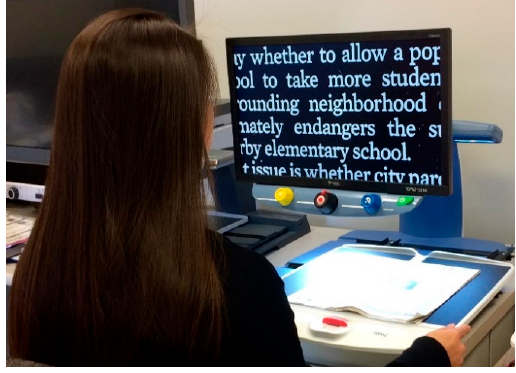
Figure 13. Desk-based electronic magnifier.